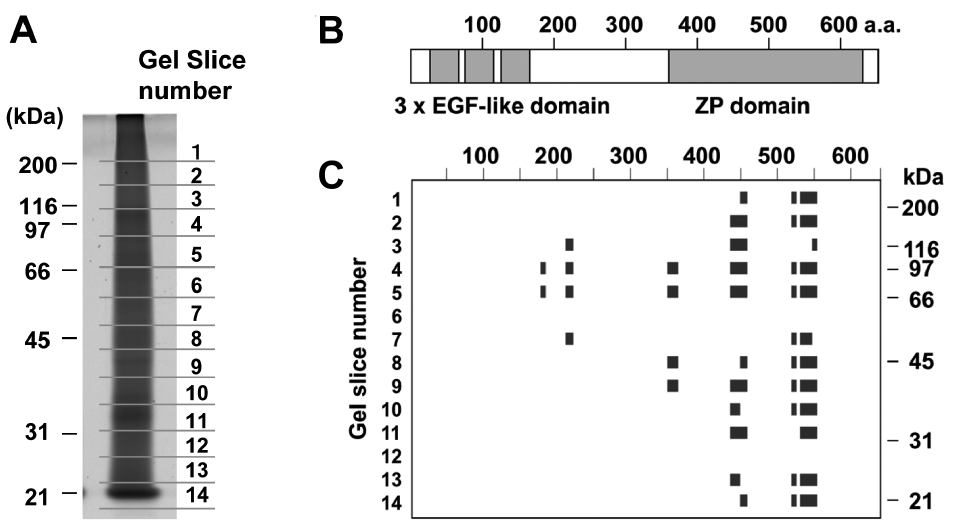
Figure 2. Characterization of gel-separated proteins from a CaOx kidney stone by nanoLC MALDI-MS/MS analysis. (A) One of the kidney stone extracts, Sample 3, was separated by SDS-PAGE, stained with Sypro Ruby, and cut into 14 pieces as indicated. Each gel piece was subjected to in gel trypsin digestion, and the resultant peptides were analyzed by nanoLC/MALDI MS/MS followed by database search on MASCOT. The results were presented as Table 2. (B) Domain structure of human THP (SwissProt : UROM_HUMAN). (C) From the results shown in Table 2, peptides matched to THP were mapped on the amino acid sequence of human THP.